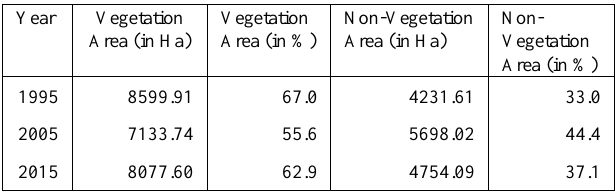
Table 2. Temporal Land Cover changes from 1995 to